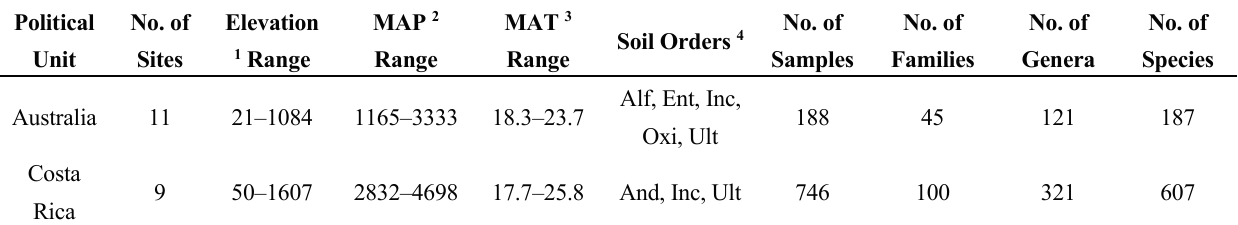
Figure 2. Map of global sampling locations for foliar spectral and non-structural carbohydrates (NSC) in tropical and sub-tropical forest tree canopies. Dots indicate the sites listed in Table 1. Site names BCI, PNM, and PNSL are Barro Colorado Island, Parque Natural Metropolitano, and Parque National San Lorenzo, respectively. Table 1. Collection sites and taxonomic partitioning of the leaf spectral and NSC